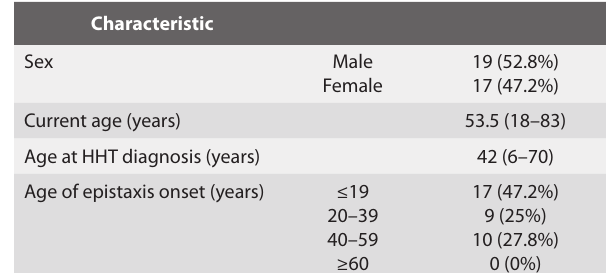
Table 1. Characteristics of the respondents.